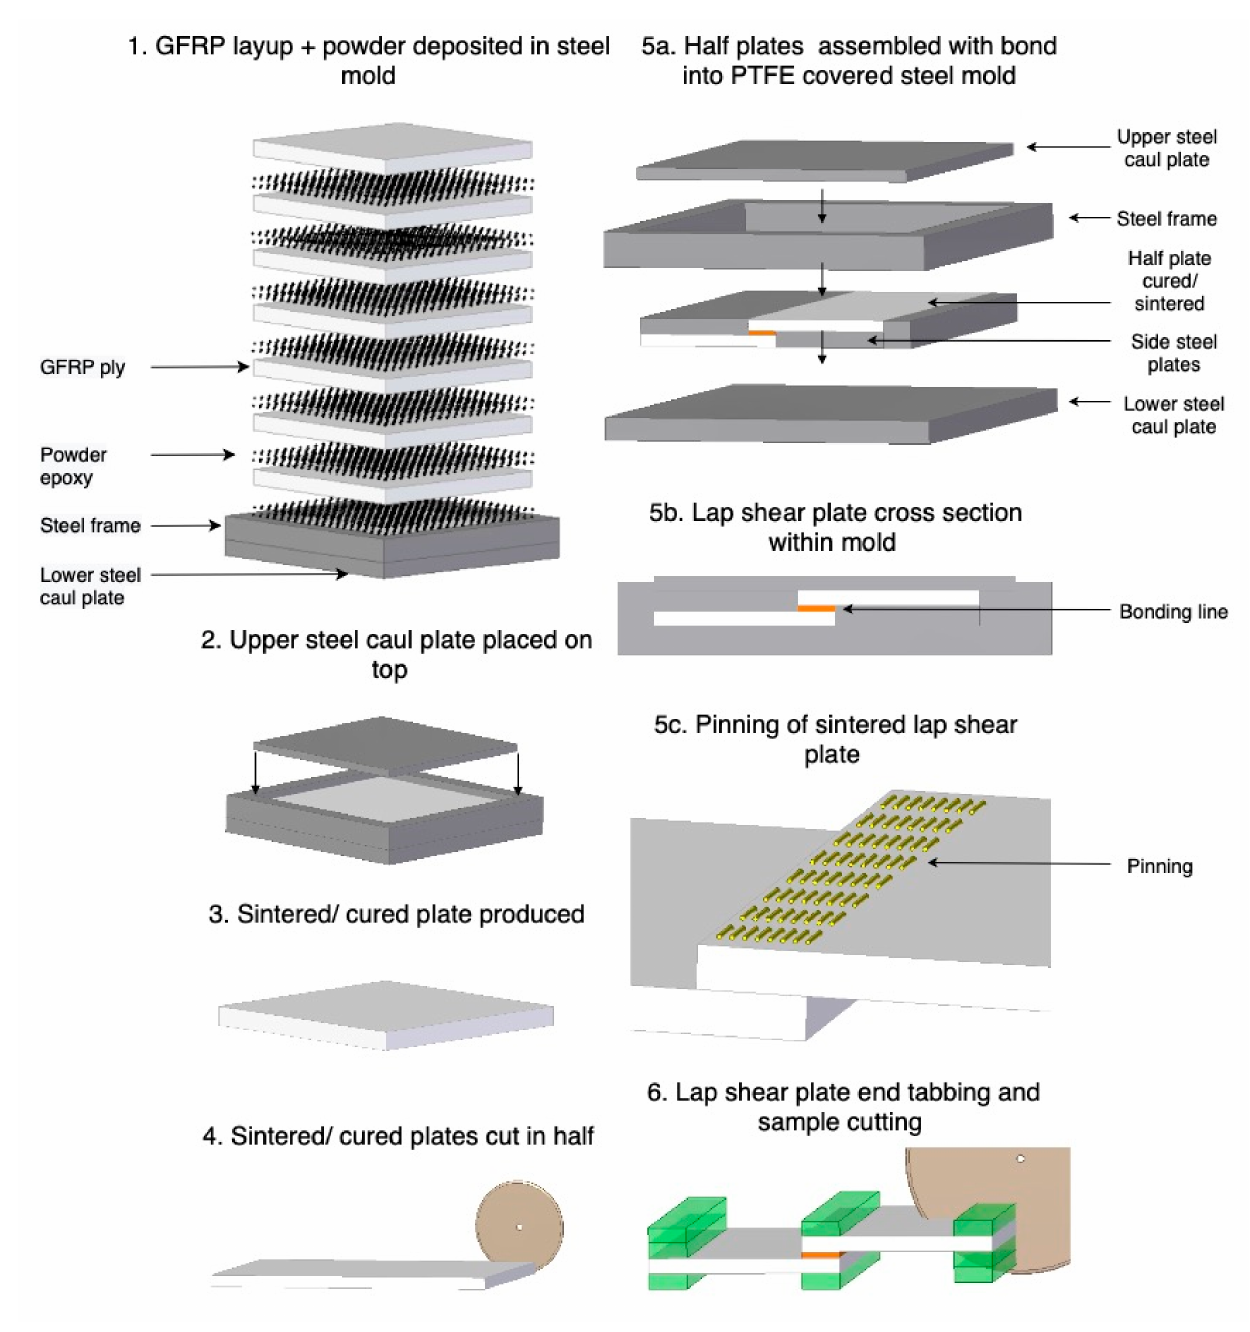
Figure 2. Initial plate and co-curing manufacturing process. Layup of plate into steel frame with upper + lower caul plate ( 1 – 2 ), sintering/curing of the plate ( 3 ), cutting plate in half ( 4 ), half plates assembled and bonded depending on case ( 5a , 5b , 5c ), lap shear plate end tabbed and samples cut ( 6